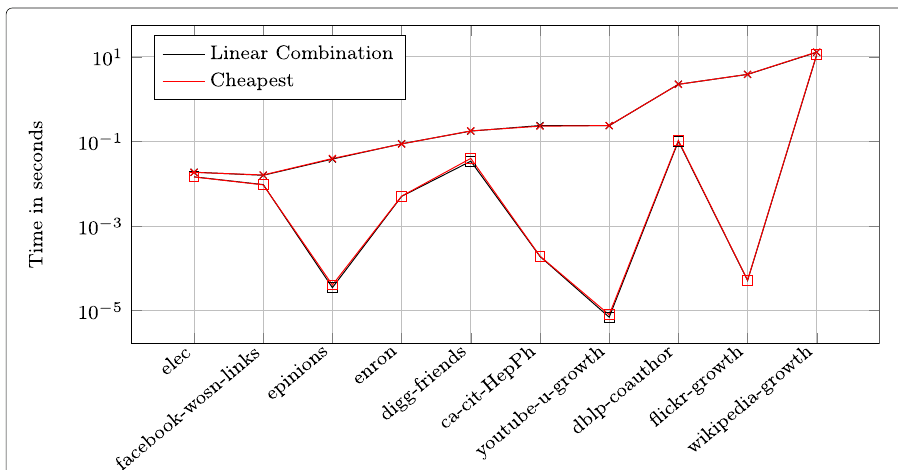
Fig. 4 Running time comparison for computing optimal walks with respect to a linear combination ( δ 1 = δ 2 = ... = δ 7 = 1) of different optimization criteria (black) and with respect to cheapest walks (red) for β ≡ T . Note that the red and black line are on top of each other and hence almost indistinguishable. The (upper) lines with crosses illustrate the average running time and the (lower) lines with boxes show the median running